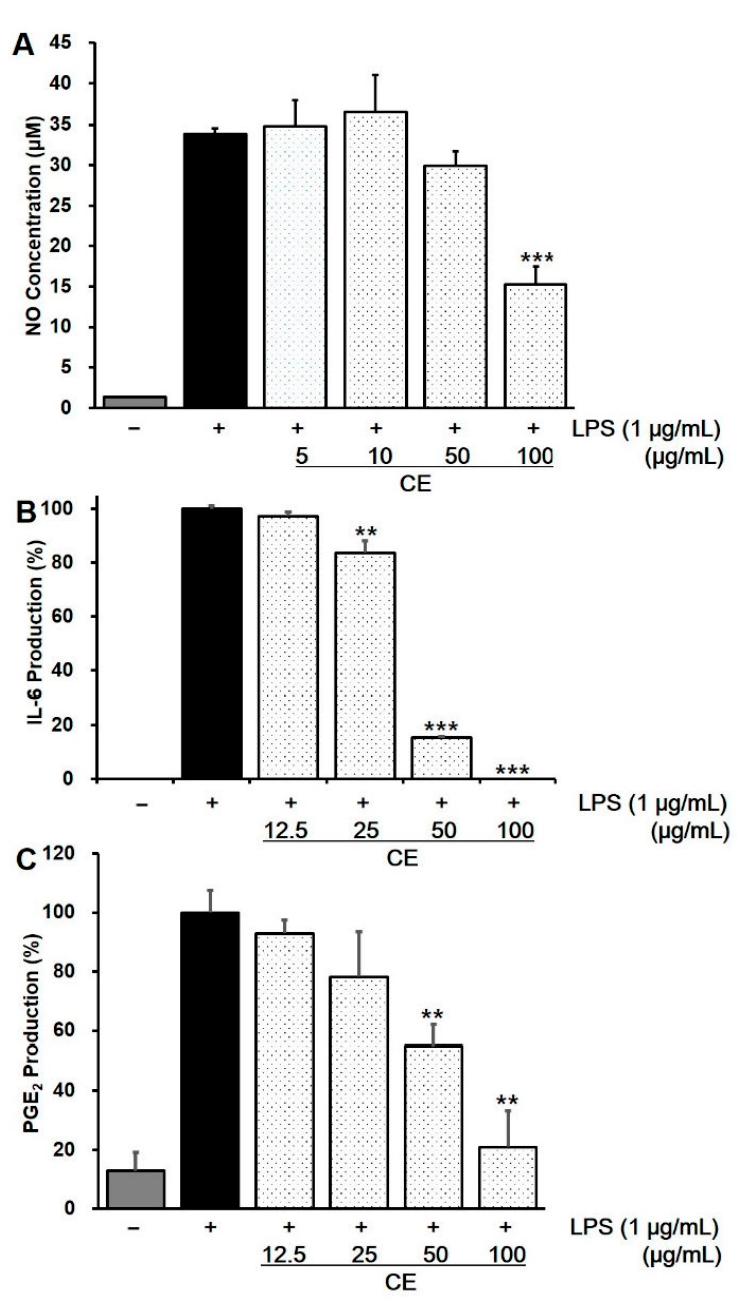
Figure 4. Effect of carotenoid extract (CE) on NO production ( A ); IL-6 production ( B ); PGE 2 produc- tion ( C ) in LPS-stimulated RAW 264.7 cells. ** p < 0.01, *** p < 0.001 vs. LPS-treated control.